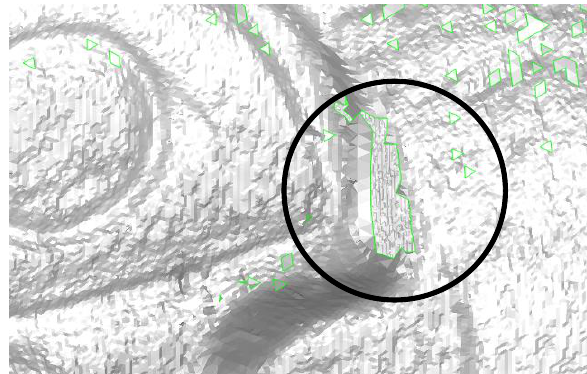
Figure 7. “Escultura 23”. Missing polygons on the nose (circled).